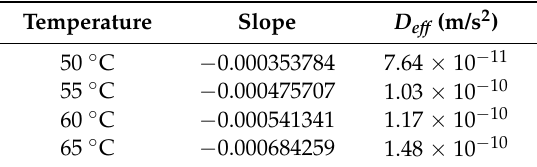
Figure 5. The change of ln(MR) by time (seconds) of sliced lemongrass. Table 3. D eff at different drying temperatures.